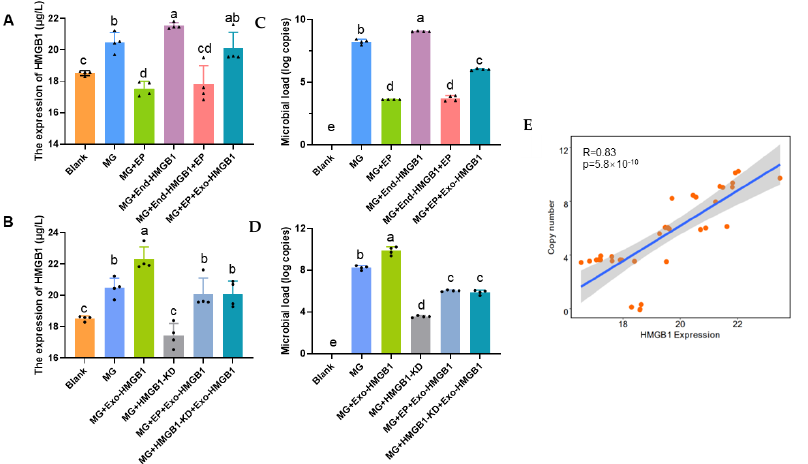
Figure 2. HMGB1 positive correlation with MG load. HD-11 cells were infected with MG for 24 h and cell supernatants ( A , B ) and cells were collected ( C , D ). The HMGB1 levels were detected by ELISA. Meanwhile, the quantity of MG was detected. EP, the HMGB1 release inhibitor; End-HMGB1, the overexpression plasmid of HMGB1; Exo-HMGB1, the HMGB1 recombinant protein. ( E ) A correlation chart between extracellular HMGB1 and MG load, their correlation degree was R = 0.83. Different lowercase letters represent p < 0.05. Black dots in bar graph represent datasets from independent experiments.